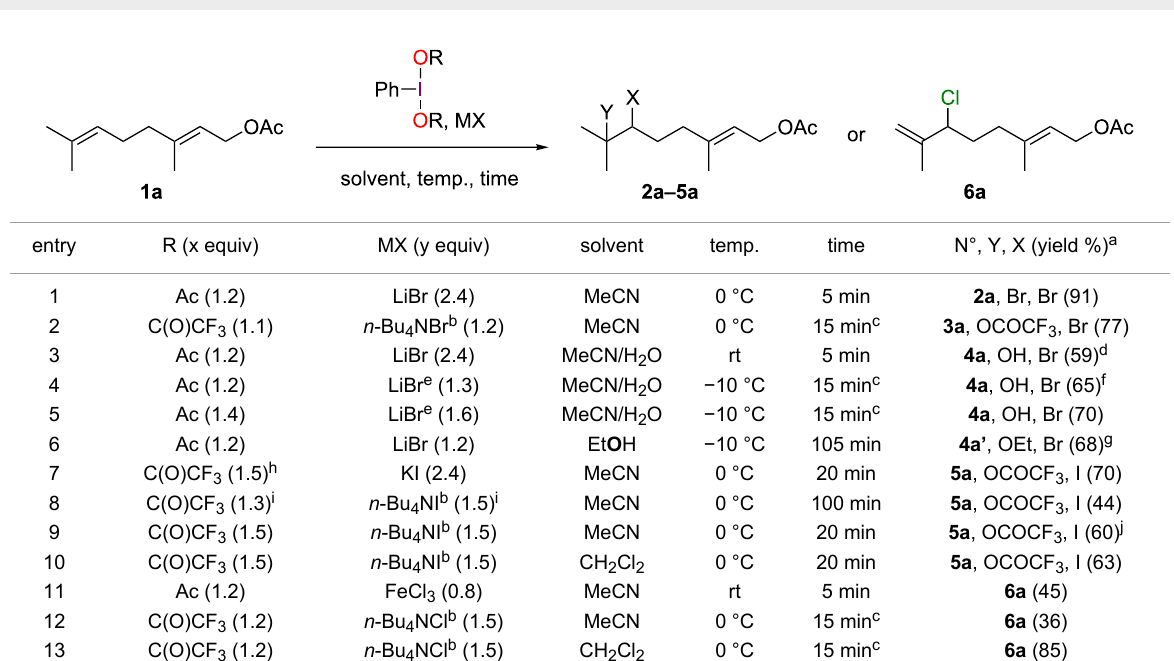
Table 1: Optimization of the reactions